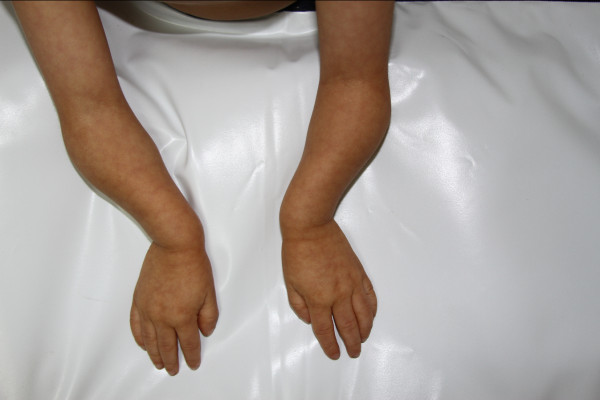
Our patient at age 5. Note the ulnar deviation of his hands.